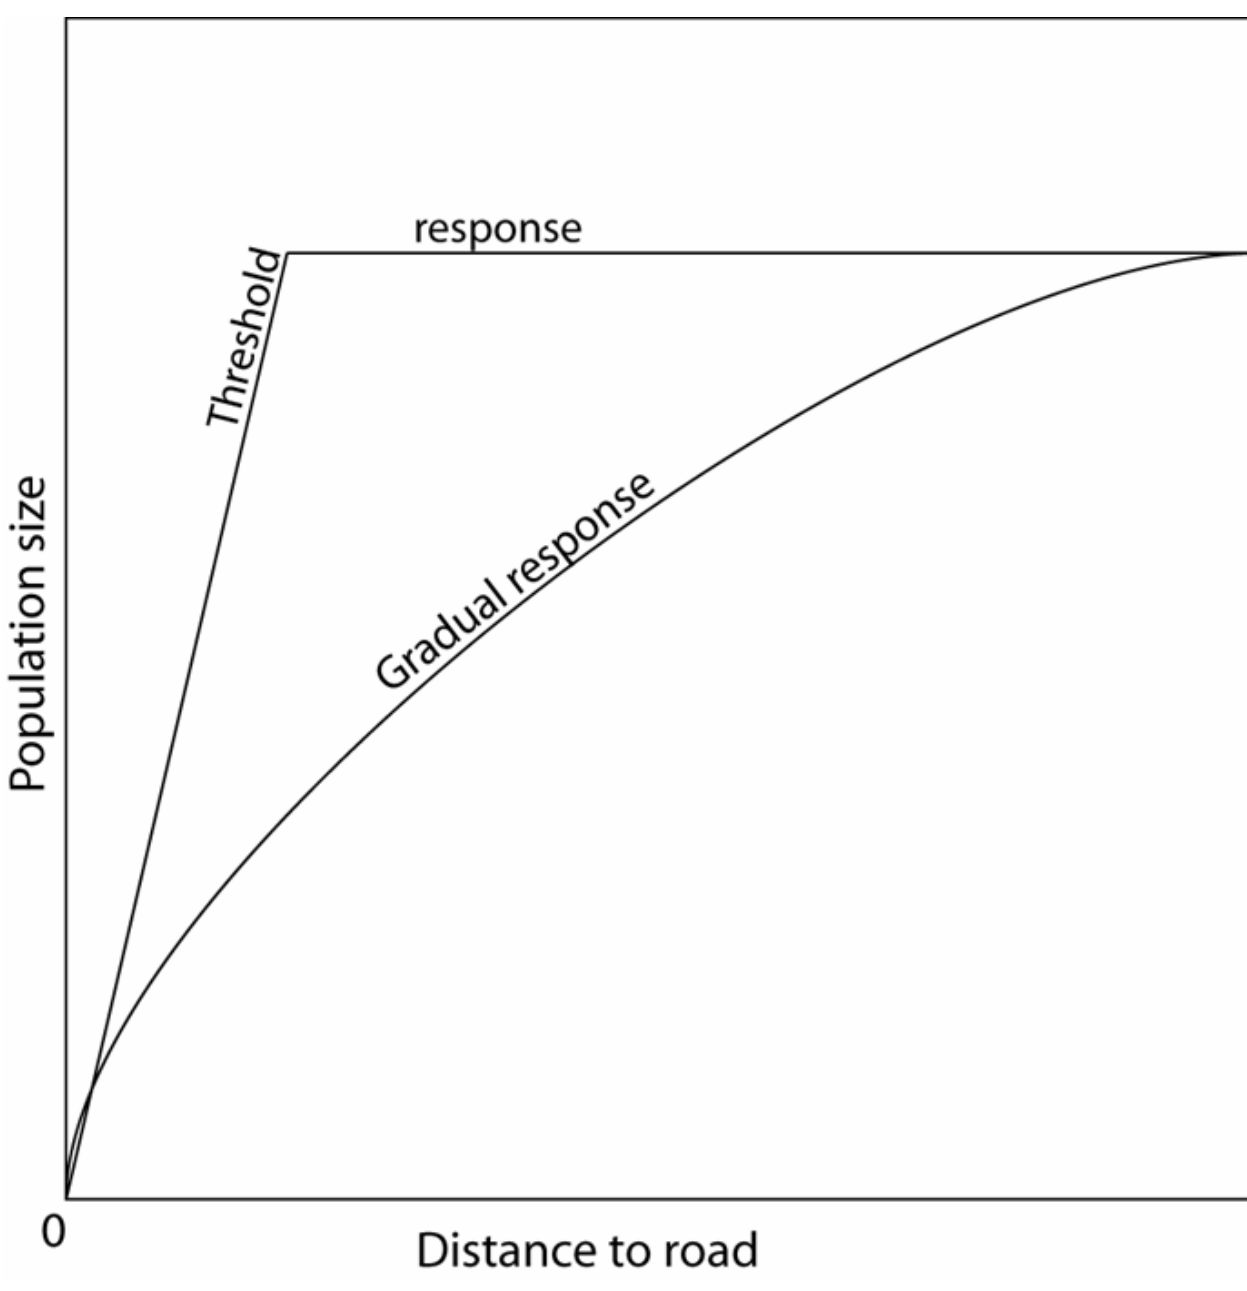
Fig. 1. An example of two types of road effect zones: one sharply defined by a threshold and the other characterized by a gradual, approximately linear increase in population size with increasing distance from the road until some distance beyond which no effect can be